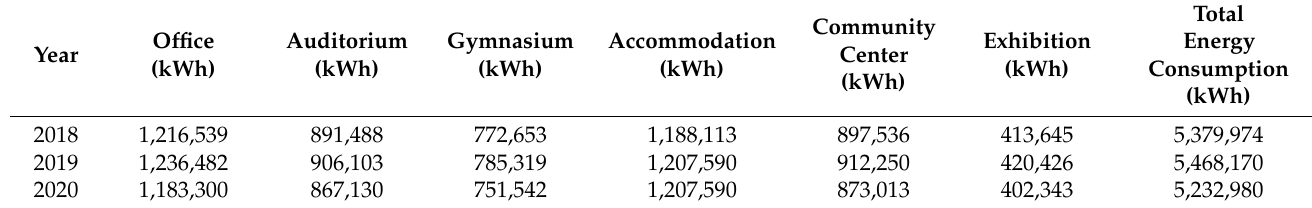
Table 3. Energy consumption of the A community buildings.